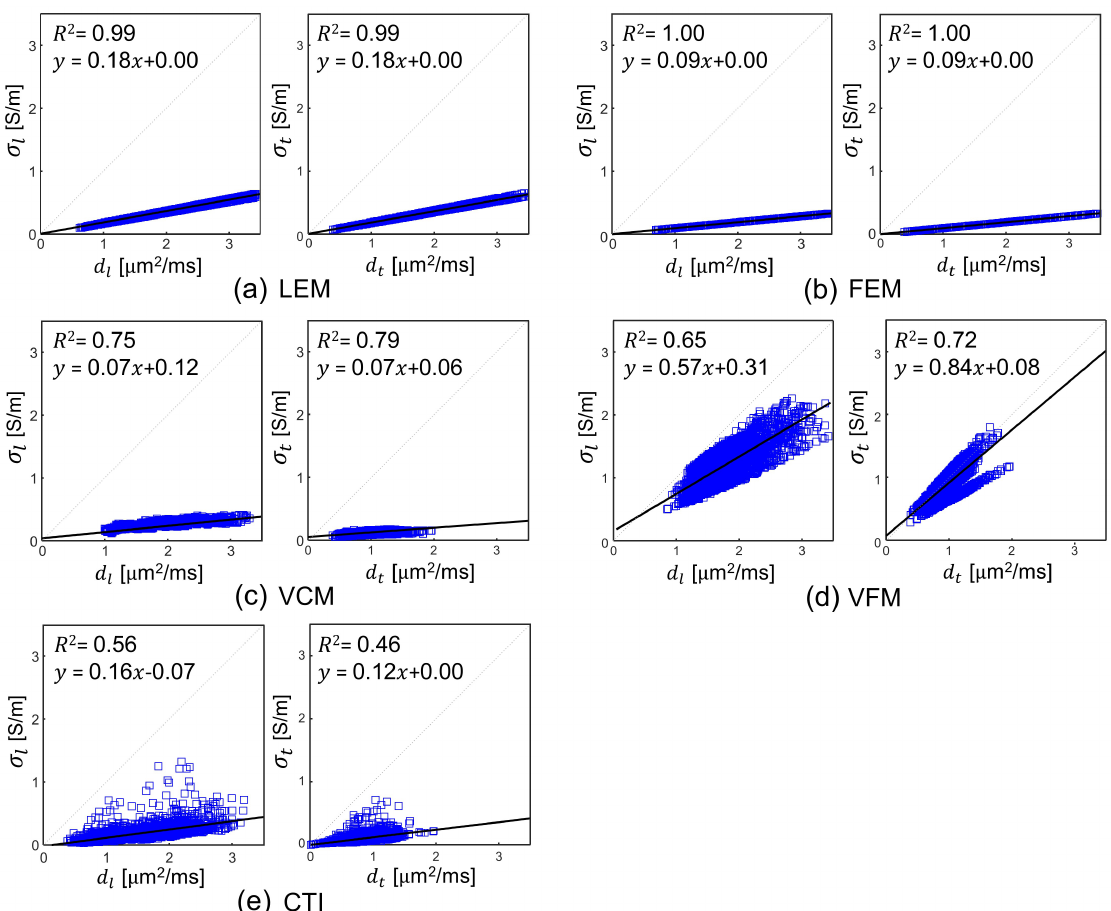
Figure 5. Results of the linear regression analyses between s l and d l , the longitudinal component of both tensors and averaged transversal components σ t = σ t 1 + σ t 2 and d t = d t 1 + d t 2 in the reconstructed conductivity and water diffusion tensor 2 2 images of all five human subjects pooled